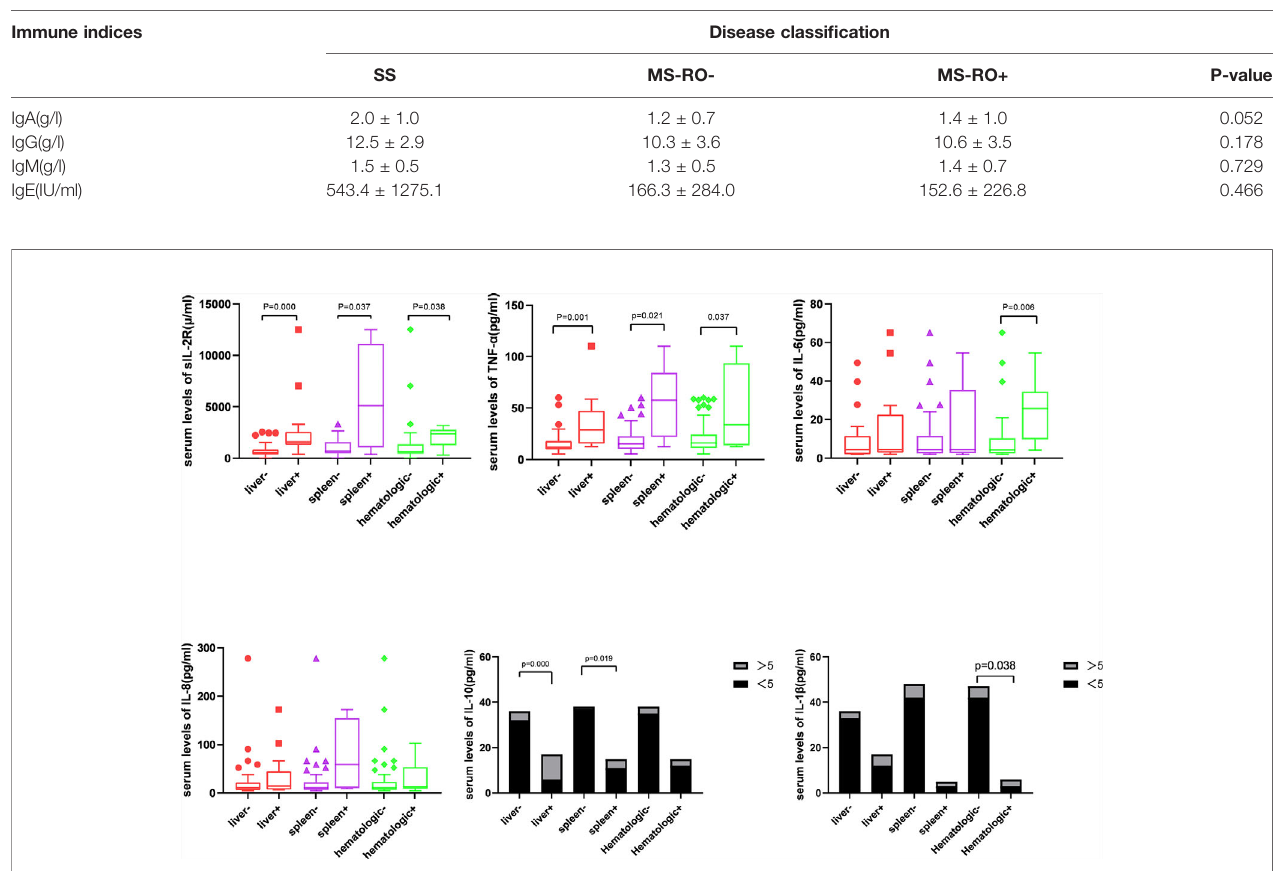
FIGURE 3 | Analysis of in fl ammatory cytokines and affected organs.